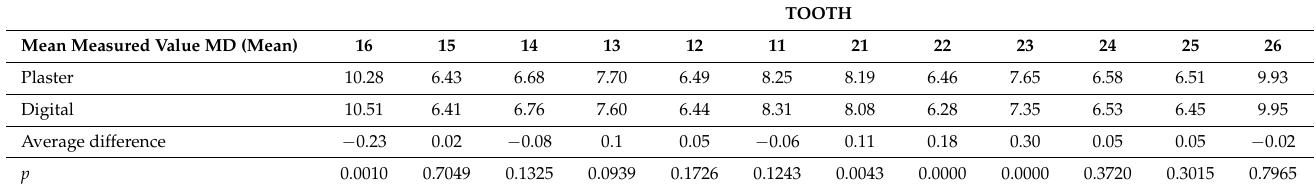
Table 1. Comparison of the mean values of the tooth width (MD) measurements in the upper arch. TOOTH